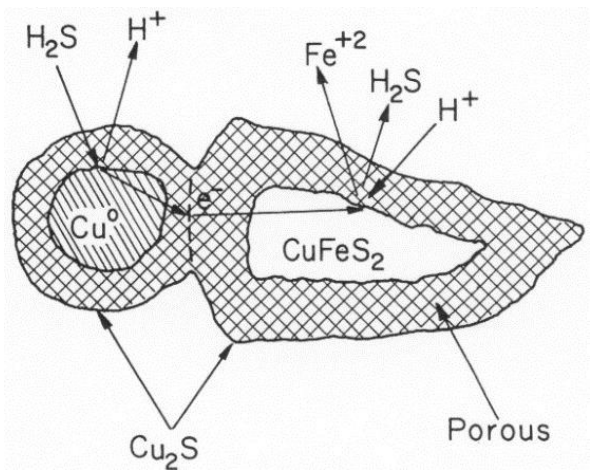
Figure 21. Schematic diagram of reactions occurring upon galvanic conversion of chalcopyrite with metallic copper [24].